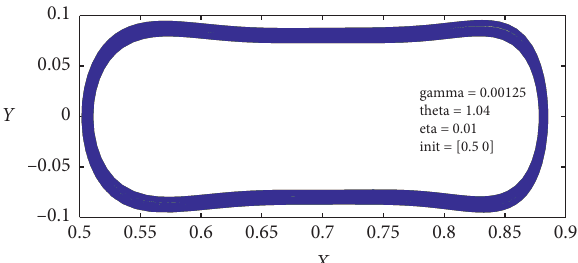
Figure 10: Phase portrait of system (7) for θ � 1 . 04, η � 0 . 01, and c � 0 . 00125. Remaining parameters are kept as in (9).